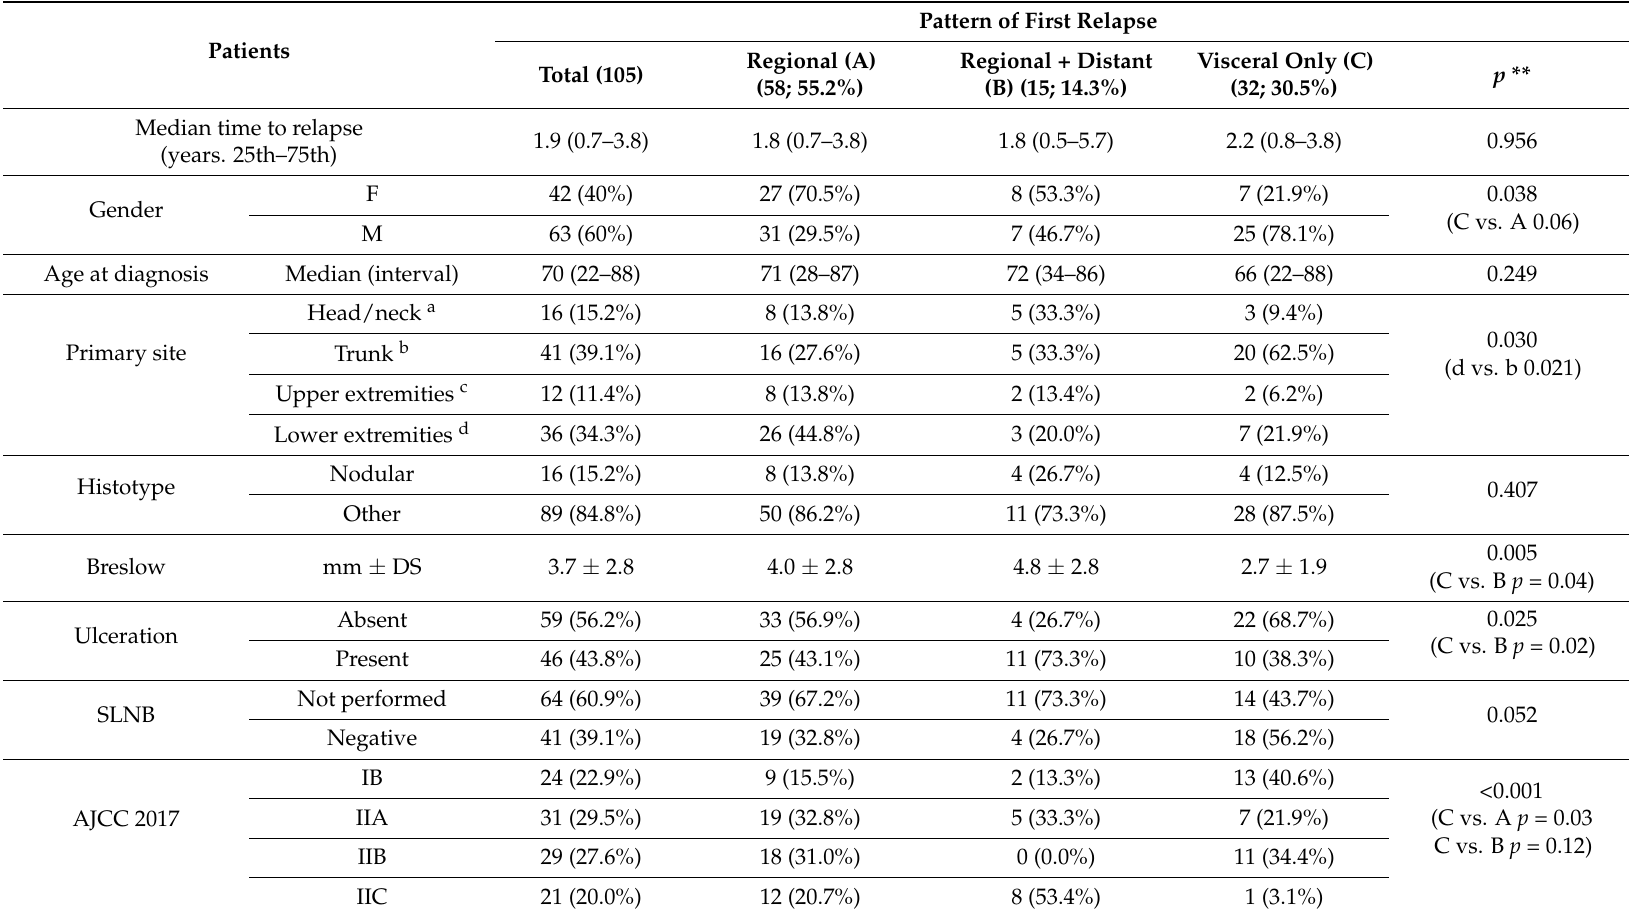
Table 1. Clinical characteristics based on the pattern of first